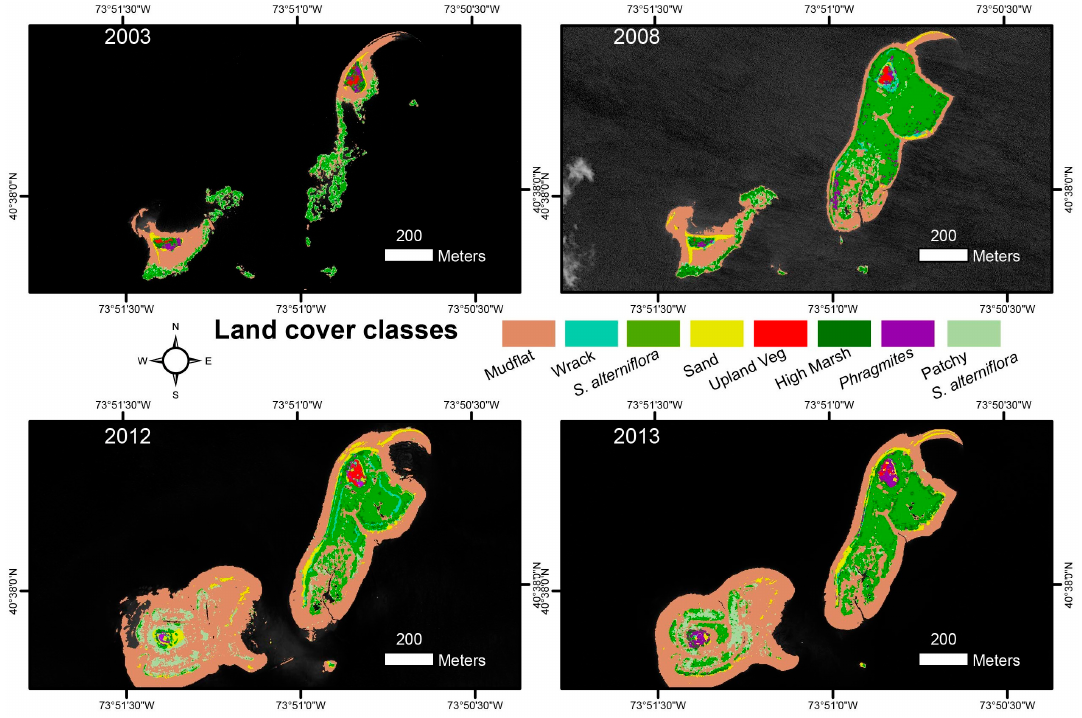
Figure 3. Salt marsh of Elders Point East and West for 2003, 2008, 2012 and 2013.